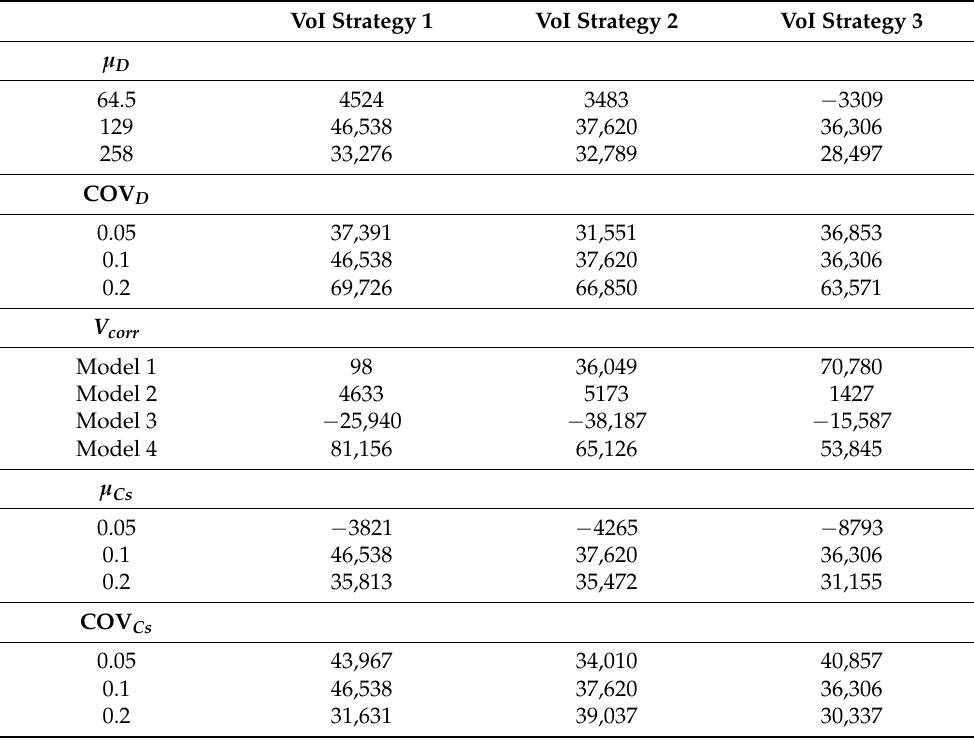
Table 5. VoI for different monitoring strategies as a function of the parameters of the distributions of the corrosion variables (for the strategies, reference is made to Table